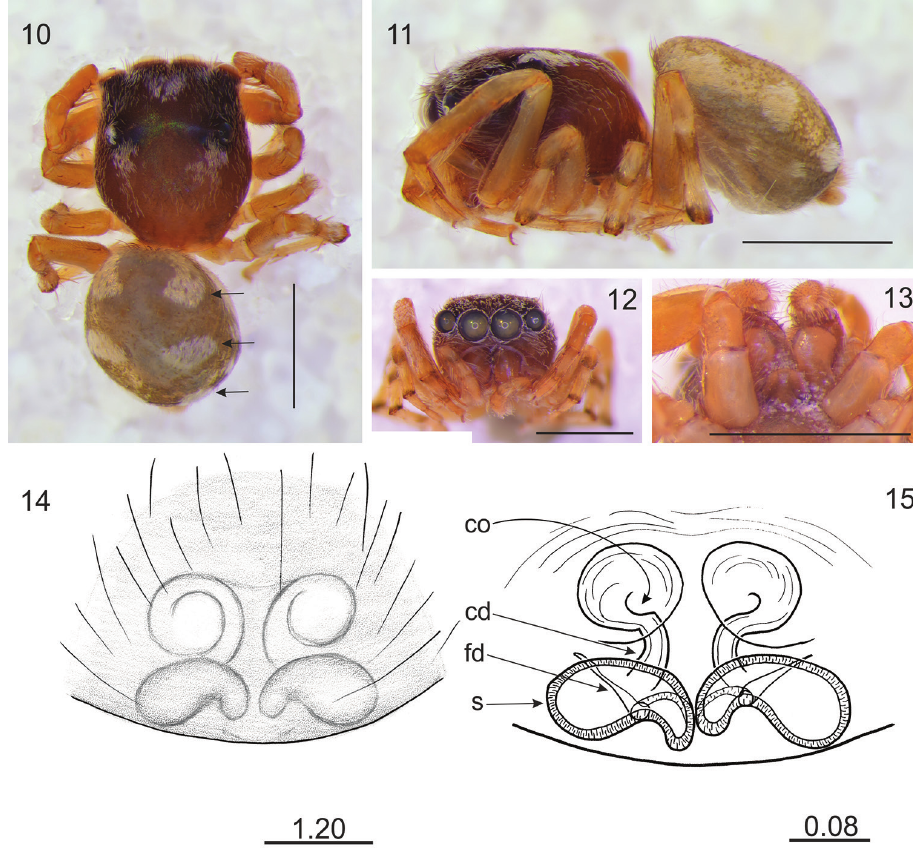
Figures 10–15. Rogmocrypta karolinae sp. n. (female holotype). 10 Dorsal view (arrows indicate patches of white scales being distinctive diagnostic characters) 11 Lateral view 12 Frontal view 13 Endites and labium 14 Epigyna 15 Vulva. Abbreviations: cd: copulatory duct, co: copulatory opening, fd: fertilisation duct, s: spermatheca. Scale bars: 1 mm ( 10–13 ); 1.20 mm ( 14 ); 0.08 mm( 15